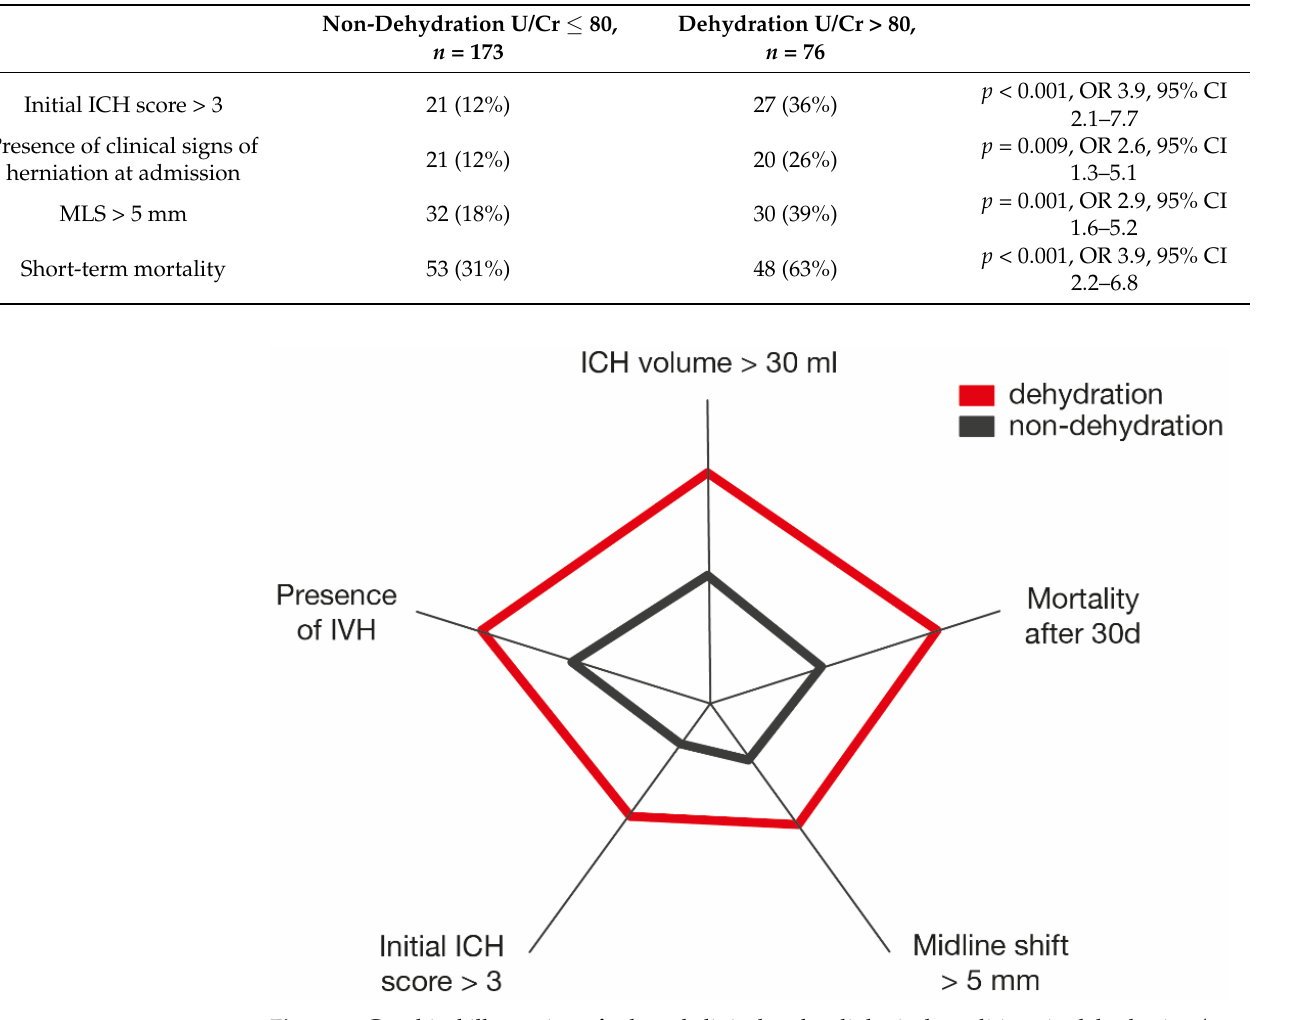
Figure 1. Graphical illustration of selected clinical and radiological conditions in dehydration/non- dehydration group and corresponding impact on mortality after 30 days. ICH, intracerebral hemor- rhage; IVH, intraventricular hemorrhage.